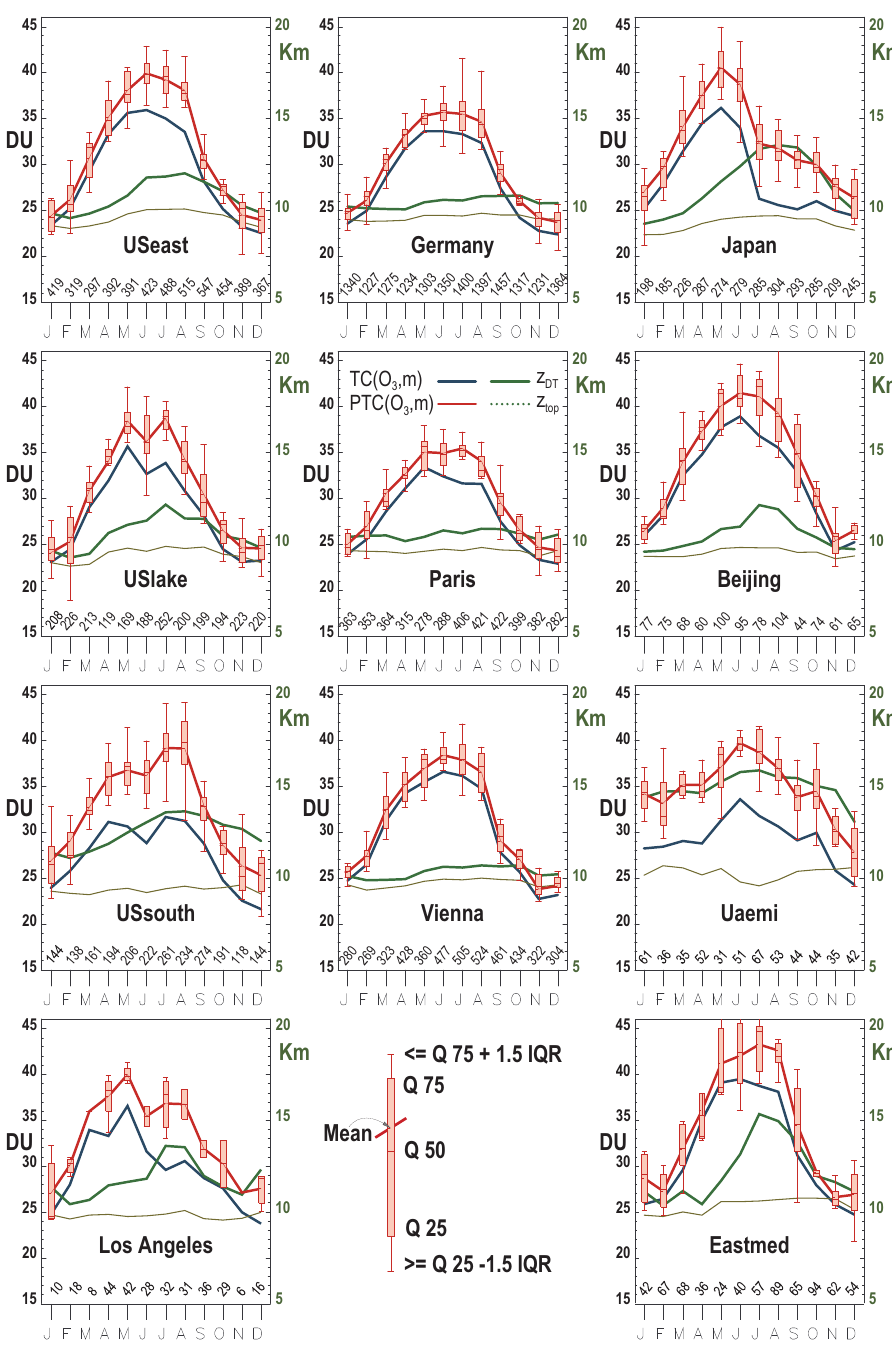
Fig. 5. Cycles of TC m ( O 3 ) , in blue, and PTC m ( O 3 ) box-and-whisker plots, in red, expressed in DU by referring to left vertical axis for USeast, USlake, USsouth, Los Angeles, Germany, Paris, Vienna, Japan, Beijing, Uaemi and Eastmed. 1 is located between the altitude (in kilometres, right green vertical axis) given by the solid green line, the monthly average of z DT in all cases, and the dotted green line, the monthly average of z DT if z DT < z top and z top if z DT > z top . Monthly sampling frequency of each site is provided above the x axis. Box uses the quartiles [Q25, Q50, Q75]. The ends of the box-and-whisker plots are the ≥ Q25-1.5IQR or ≤ Q75+1.5IQR, where IQR is the interquartile